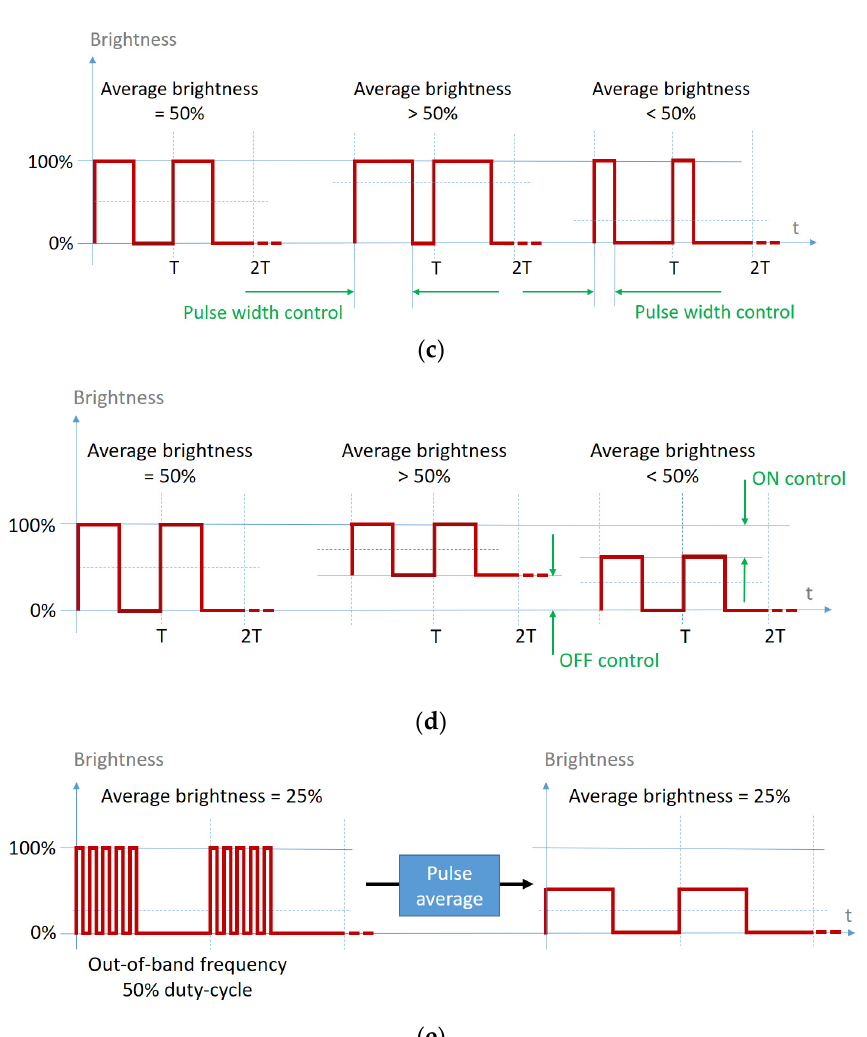
Figure 2. Light dimming in VLC: ( a ) The frame structure for the method of inserting compensation symbols; ( b ) Example of controlling the brightness in OOK modulation by adding compensation symbols; ( c ) Example of controlling the brightness in OOK modulation by pulse width variation; ( d ) Example of varying the brightness by controlling the amplitude of ones and/or zeros; ( e ) Example of varying the brightness in the out-of-band frequency.